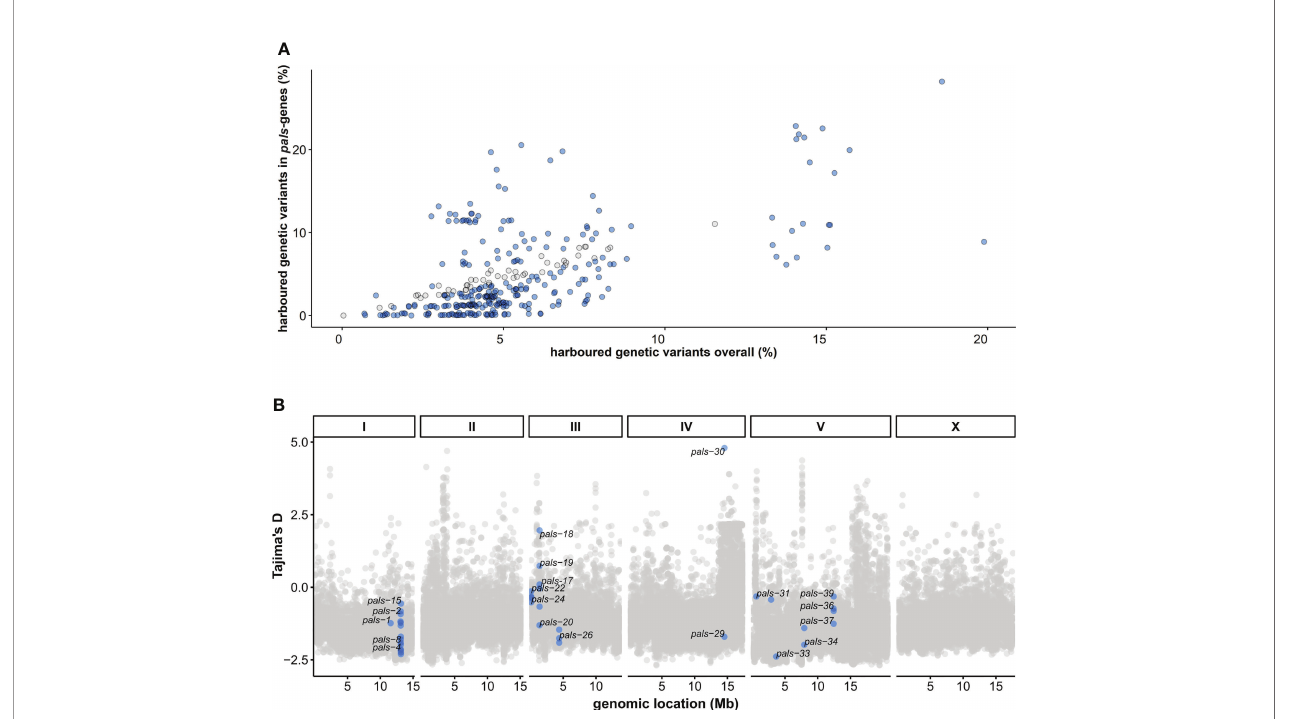
FIGURE 1 | Natural variation in the C. elegans pals -gene family worldwide – (A) The percentage of genetic variants (de fi ned by SNPs) in the pals -gene family compared to the overall natural variation for each of the 330 wild isotypes (Cook et al., 2017). The number of SNPs is relative to the reference strain N2. Blue dots indicate the amount of variation in the pals -genes is different than expected from the overall natural variation (Chi-square test, FDR < 0.0001). (B) Tajima ’ s D values per gene in the C. elegans genome calculated from sequence data of the 330 wild strains in the CeNDR database (Cook et al., 2017). Blue dots indicate Tajima ’ s D values for pals